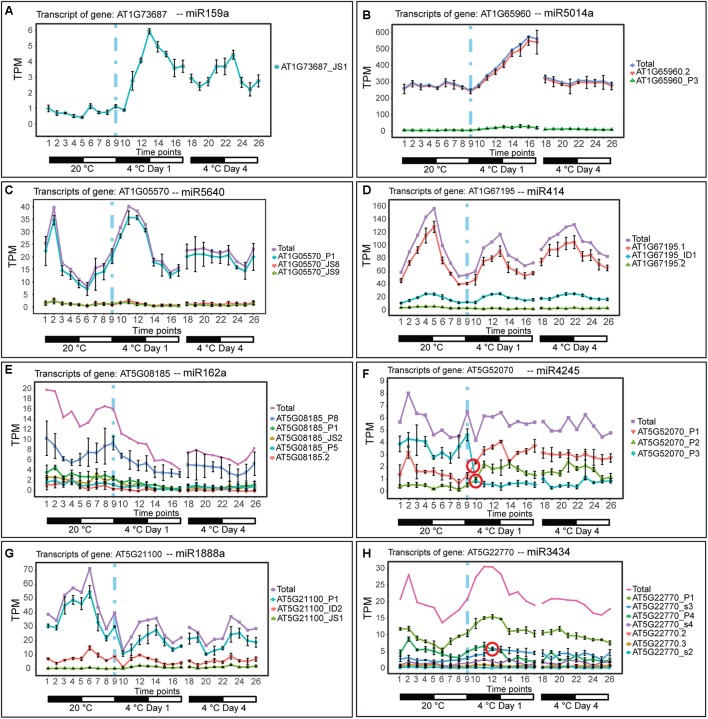
Expression of pri-miRNA transcripts in response to cold. Transcripts below 1.85 TPM in all time-points are not shown (except in H, where we used a 1 TPM cut-off value). Transition to cold is represented by a vertical dashed blue line at time-point 9. (A) pri-miR159a is DE showing a significant upregulation upon cold and a gain of a high amplitude rhythm is also observed. (B) pri-miR5014a, is an intronic miRNA in the GLUTAMATE DECARBOXYLASE 2 gene (AT1G65960); the profile of the pre-mRNA is DE showing a significant upregulation only in the first day of cold treatment. (C) pri-miR5640 is an intronic miRNA in CALLOSE SYNTHASE 1 (AT1G05570) which is DE in the cold, while upon longer exposure to cold (day 4) rhythmicity is lost/dampened. (D) pri-miR414 is rhythmically expressed and not significantly affected by cold. (E) pri-miR162a is DE and DAS showing a significant downregulation throughout the cold treatment. (F) pri-miR4245 is intronic in an AGENET DOMAIN-CONTAINING PROTEIN gene (AT5G52070) which undergoes splicing regulation with no significant expression change at the gene level. (G) pri-miR1888a is an intronic miRNA in an L-ASCORBATE OXIDASE gene (AT5G21100) that is downregulated at the transcriptional level and undergoes differential alternative splicing. (H) pri-miR3434 is an intronic miRNA in an ALPHA-ADAPTIN gene (AT5G22770) which undergoes only splicing regulation. Rapid and significant isoform switches detected by TSIS (Guo et al., 2017) are labeled with a red circle.